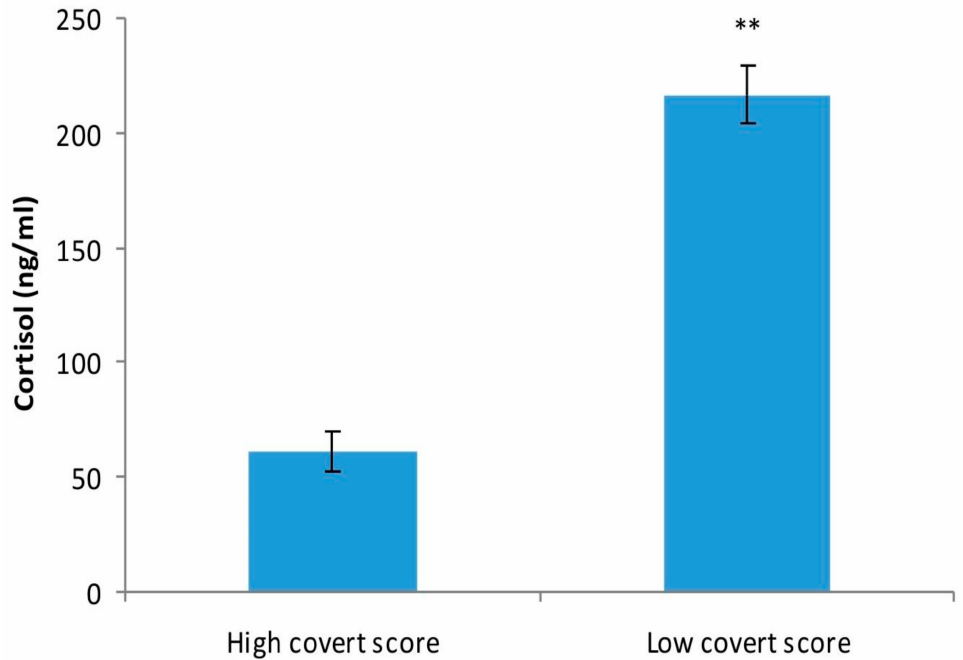
Figure 1. Cortisol level (ng/mL) in patients with a higher level of covert aggression and patients with a lower covert aggression score, as studied by two-tailed, unpaired Student’s t -test. The values are mean ± S.D. ( n = 14 per group). ** p <